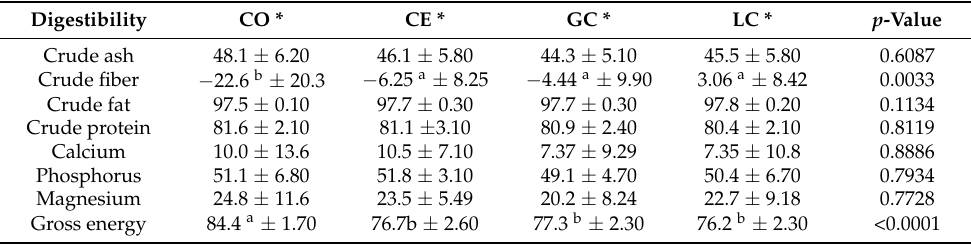
Table 2. Apparent digestibility of selected parameters (%) of diets offered to dogs with various fiber sources (mean ±